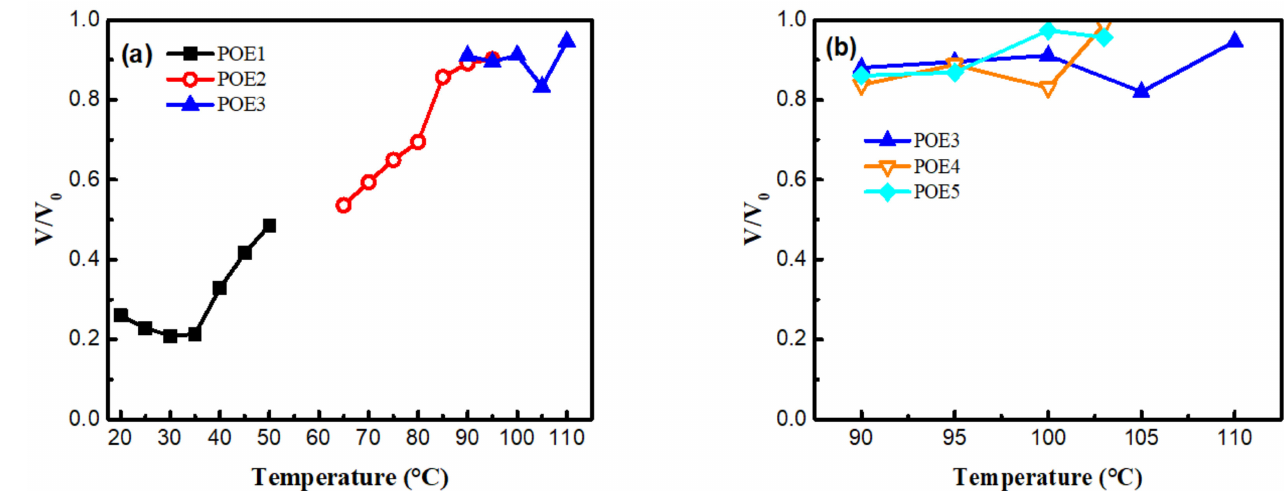
Figure 13. V/V 0 of POE foams obtained at different temperature. V/V 0 is the volume ratio after 21 days for aging and the first test at the time of 1 min ( a ) POE samples with same MI; ( b ) POE samples with same octene content.